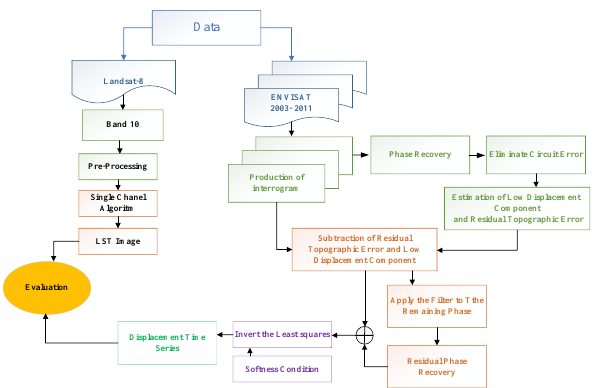
Figure 3. Map of the average annual displacement rate of the earth's surface along the line of sight of the satellite (in meters Figure 2. Flowchart of the fundamental work steps. per year) resulting from SBAS algorithm (a), Surface temperature map for the study areas (b).  DISCUSSION AND RESULTS regular pattern, the lowest temperature is assigned to the northern part of the plain and the highest temperature is assigned to its middle and southern parts. By overlapping LST and surface displacement maps, only 6 volcanoes have both displacement and temperature values (Figures, 1,3), some of the mud volcanoes do not have the recorded value in both maps. In order to have a better visual understanding, a buffer with a radius of 500 meters is created around each of 6 mud volcanoes in surface displacement and LST maps separately. the result presents in Figure